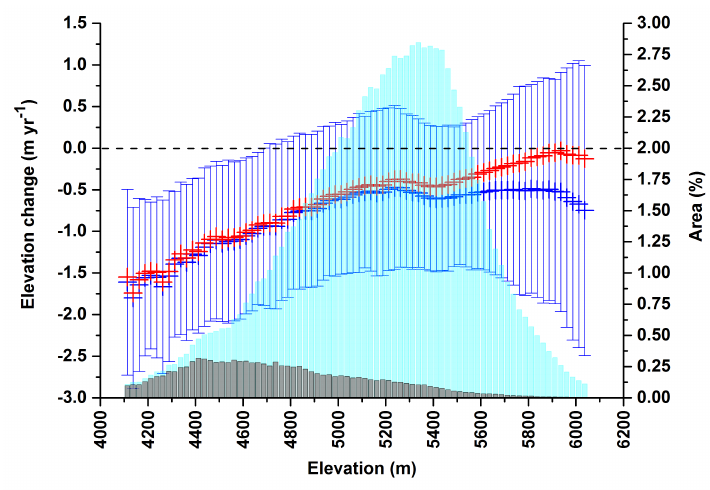
Figure 4. Hypsometric elevation change plot of the observed glaciated area of Lahaul-Spiti region ( ∼ 1712 km 2 ) using 25 m elevation bins. The cyan and gray columns show the fraction of total glaciated area and debris covered area in the corresponding bins. The blue “ + ” and 2D range plots show the median and ± NMAD elevation change (2000–2012) respectively in the corresponding bins after correcting the C- and X- band penetration bias. The red “ + ” indicate the uncorrected median elevation change. Table 2. The glacier characteristics such as area, percentage of measured area in the study, fraction of debris-covered area, terminating to lake or land, mean slope and orientation. Elevation change ( dh / dt ) before and after correcting for the C- and X-band penetration bias, corrected volume change and geodetic mass balance using Case A, B and C density assumptions during 2000–2012 and 2012–2013. The density of 900 kg m − 3 and 850 kg m − 3 are assumed for Case A and Case B respectively. Case C Mean altitude of firn line is taken as 5325 m a.s.l. from